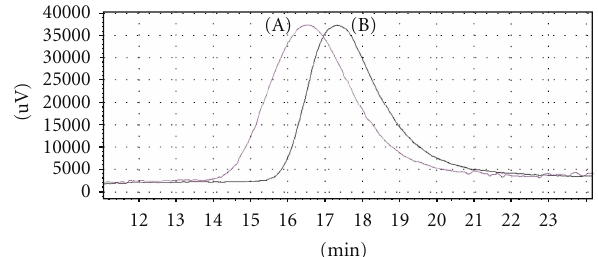
Figure 6: PCL synthesised with α -methylstyrene as a protector (A) and without a protector (B).